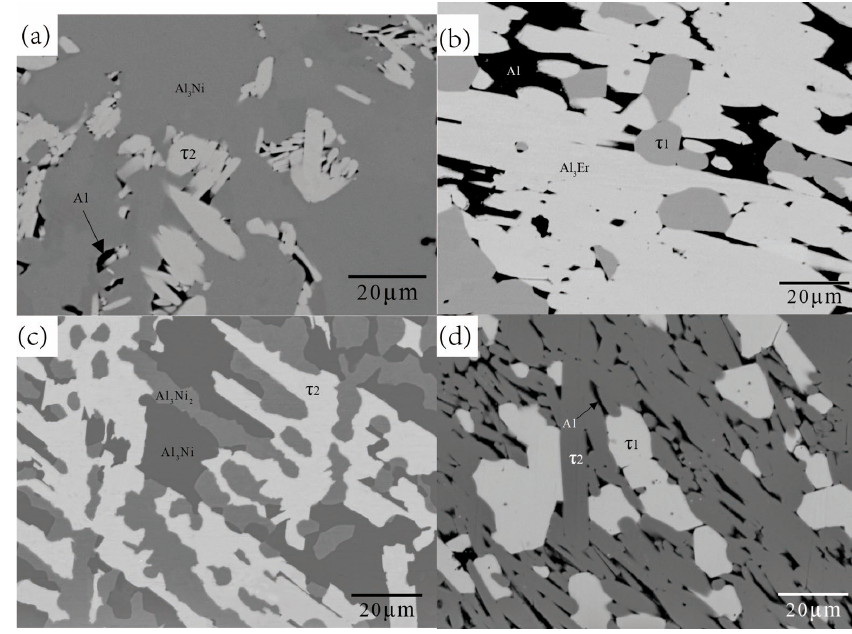
Figure 7. BSE micrographs of Alloys ( a ) A2, ( b ) A1, ( c ) A4, and ( d ) A6. 5.1.2. Isothermal Section at 700 °C The phase equilibria in the Al-rich corner of the ternary Al–Ni–Er system at 700 °C were also investigated in this work. About 30 alloy samples with different components were annealed at 700 °C for 30 days, and the data of 9 samples were chosen according to the compositions. Table 3 lists the constituent phases and nominal compositions of these alloys . Table 3. Constituent phases and nominal compositions in the annealed alloys at 700 °C. Alloy (No.)